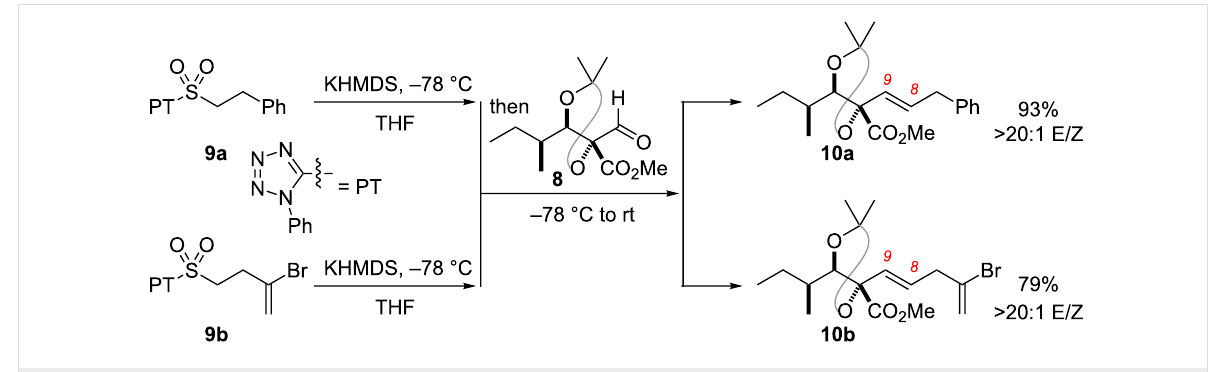
Scheme 4: Modified Julia olefination as a step-efficient alternative endgame strategy.